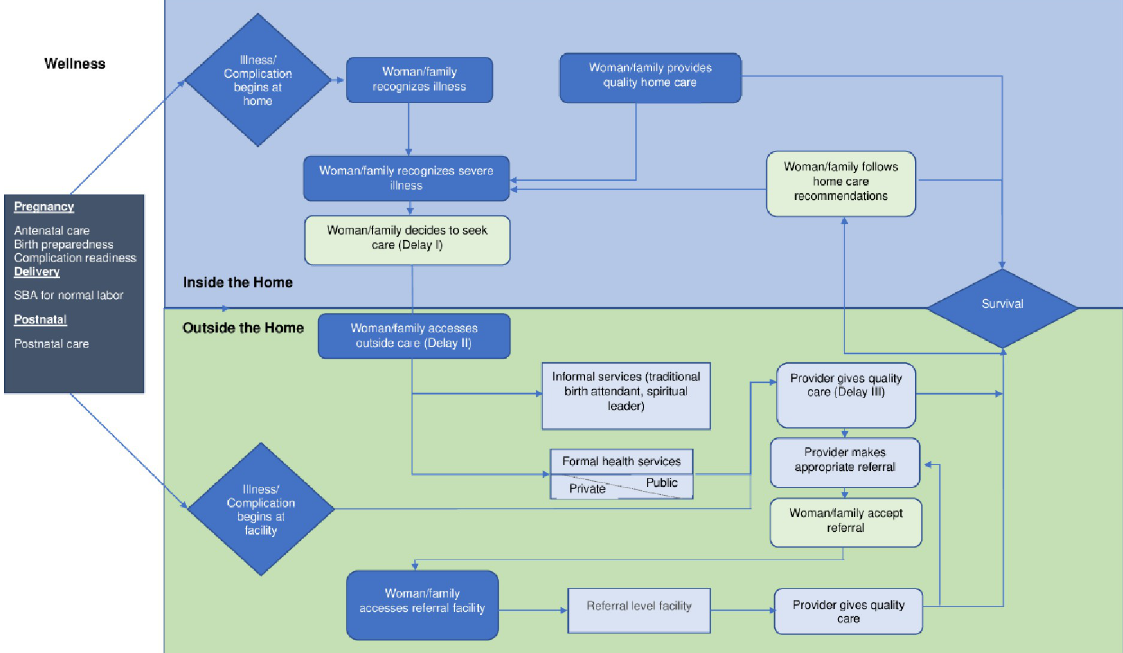
Fig 2. Care-seeking pathways among pregnancy-related deaths. This pathway was adapted from the Pathway to Survival for children developed to support the WHO/UNICEF Integrated Management of Childhood Illness approach